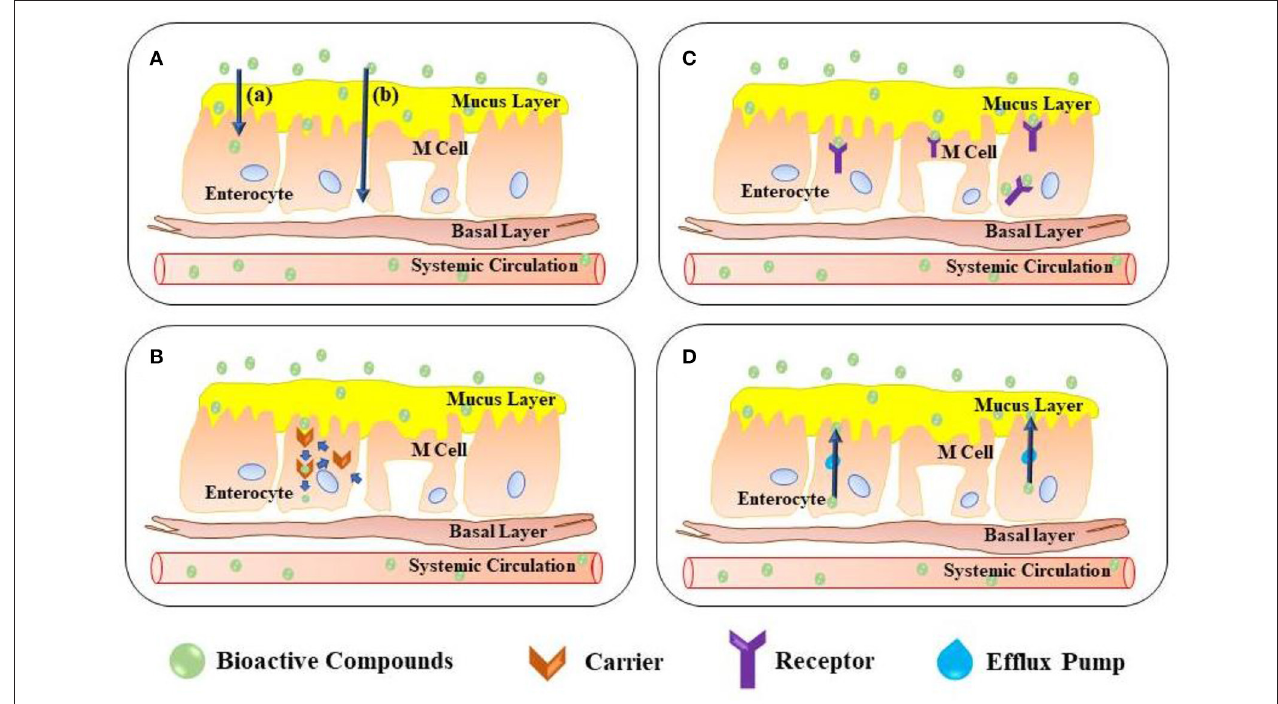
FIGURE 1 | Transport mechanisms for bioactive components through intestinal absorption cells. (A) Passive diffusion in transport mechanisms provides an energy-independent route due to osmotic pressure, either by paracellular or transcellular pathway ( 11). Both pathways defining the mechanism, (a) the pathway of transcellular diffusion in a process where small hydrophobic molecules combine and are then transported into the membrane, while (b) another pathway of paracellular diffusion happens when the junctions of the intestinal epithelium cells are carried by small hydrophilic molecules; (B) Transportation mediated by carrier permits the introduction or expulsion of BACs from cells due to osmotic pressure gradients used by cellular protein transporters. These carriers include energy-dependent active transportation and easier diffusion; (C) Transportation mediated by the receptor, in which BACs are directly bound and internalized by cells to cell-surface receptors; and (D) In the mechanisms of efflux pumps, the most important ATP-based efflux pump of which is a p -glycoprotein ( p -GlyP) in the intestinal epithelium cells. The use of a p -GlyP pathway to pump out BACs from enterocytes, leading to limited biological supply. This process has been reported to specifically affect the poor bioavailability of